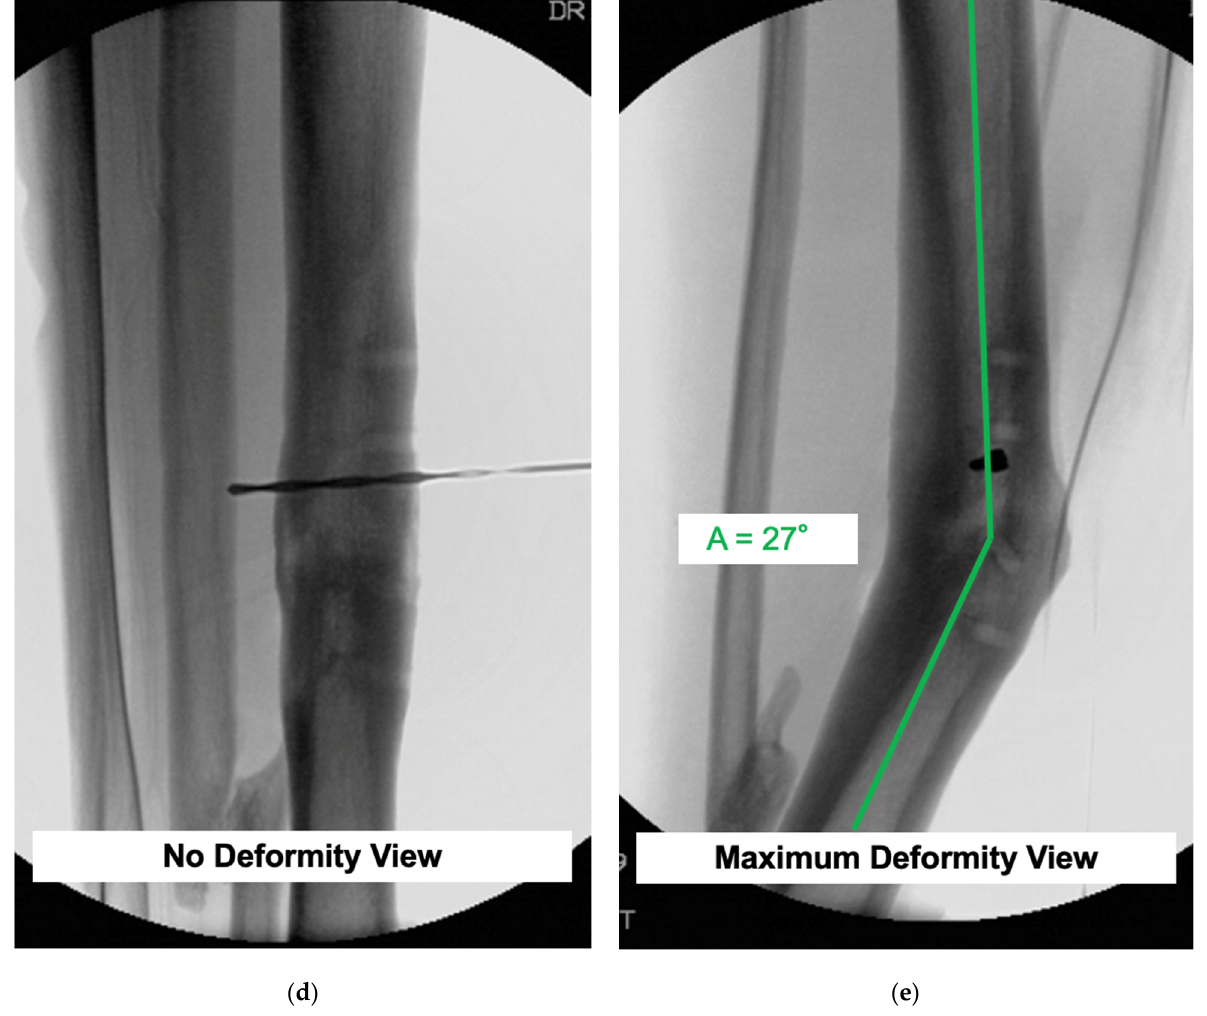
Figure 7. See Case 1 description for details. ( a – e ) demonstrate how to calculate the true angular deformity (A) and the orientation angle ( α ) from coronal and sagittal plane radiographs.